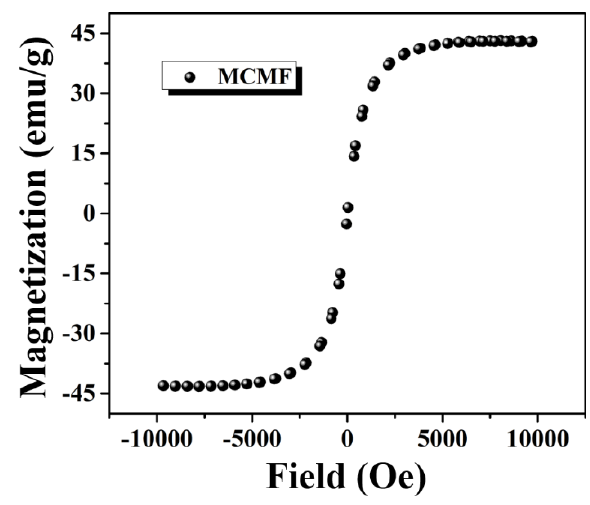
Figure 4. VSM curve of MCMF.